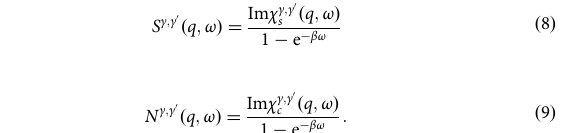
Fig. 9 Comparative analysis of the charge excitations in the Cu − O pd - model. Results were obtained using the determinant quantum Monte Carlo (DQMC) and density matrix renormalization group (DMRG) methods. Panels a − d show the dynamical charge structure factor N ( q , ω ) as a function of energy ω at q = π / a for fi llings of a h ^ n i ¼ 0 : 9, b h ^ n i ¼ 1 : 1, c h ^ n i ¼ 0 : 8, and d ^ n ¼ 1 : 2, respectively. The DQMC spectra (blue line) have been fi t with a set of Gaussian distributions, whose energies correspond well with the main peaks observed in the DMRG data (black line). The parameters for the pd -model, which includes the full Cu and O basis, are identical to those used in Figs. 4 and